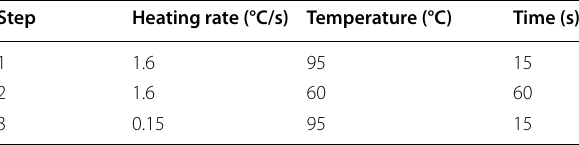
Table 4 qRT-PCR reaction system: melting curve reaction conditions